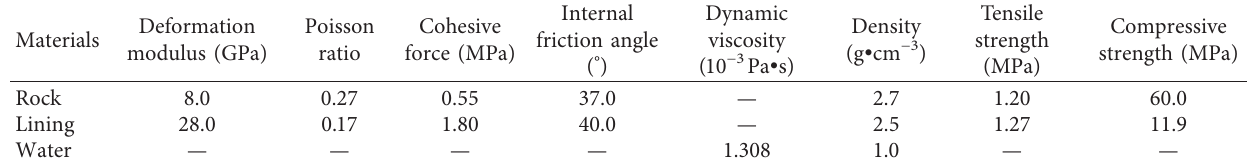
Table 1: Physical and mechanical parameters of rock, lining, and